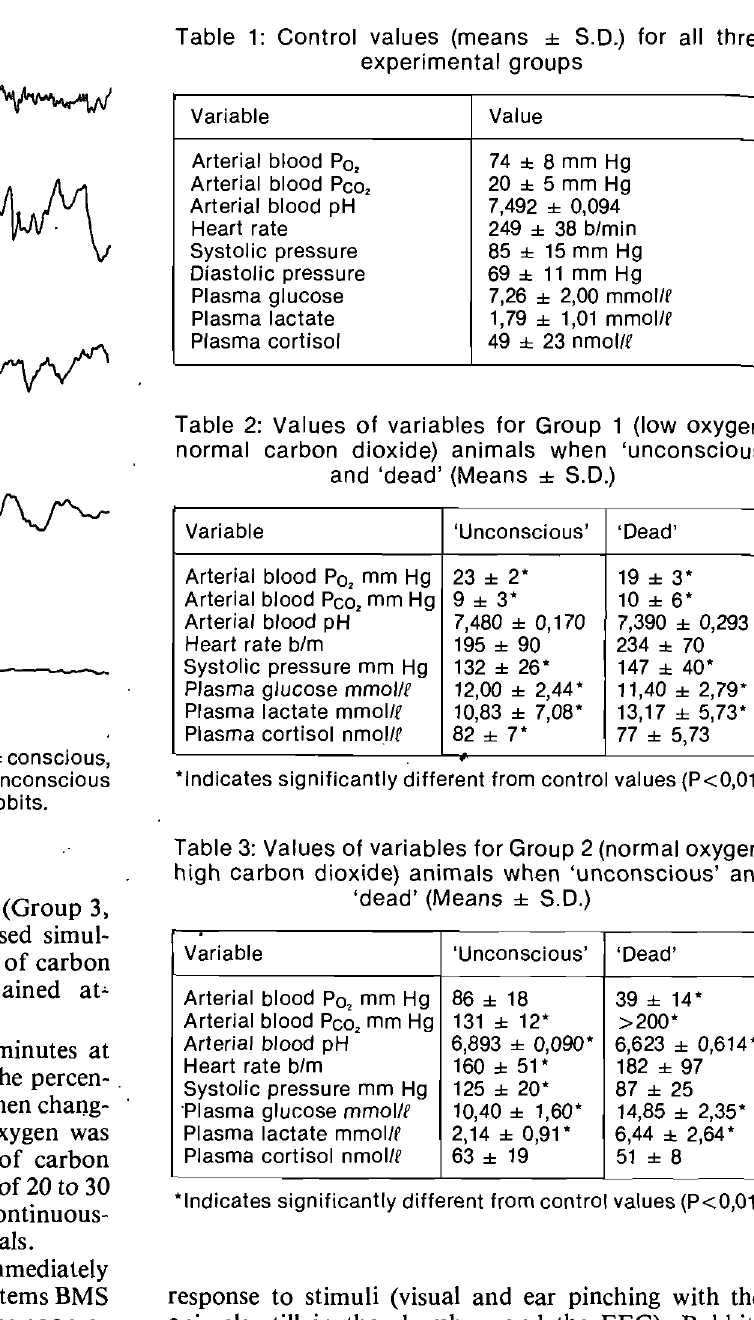
Table 2: Values of variables for Group 1 (low oxygen, normal carbon dioxide) animals when 'unconscious' and 'dead' (Means ± S,D.)